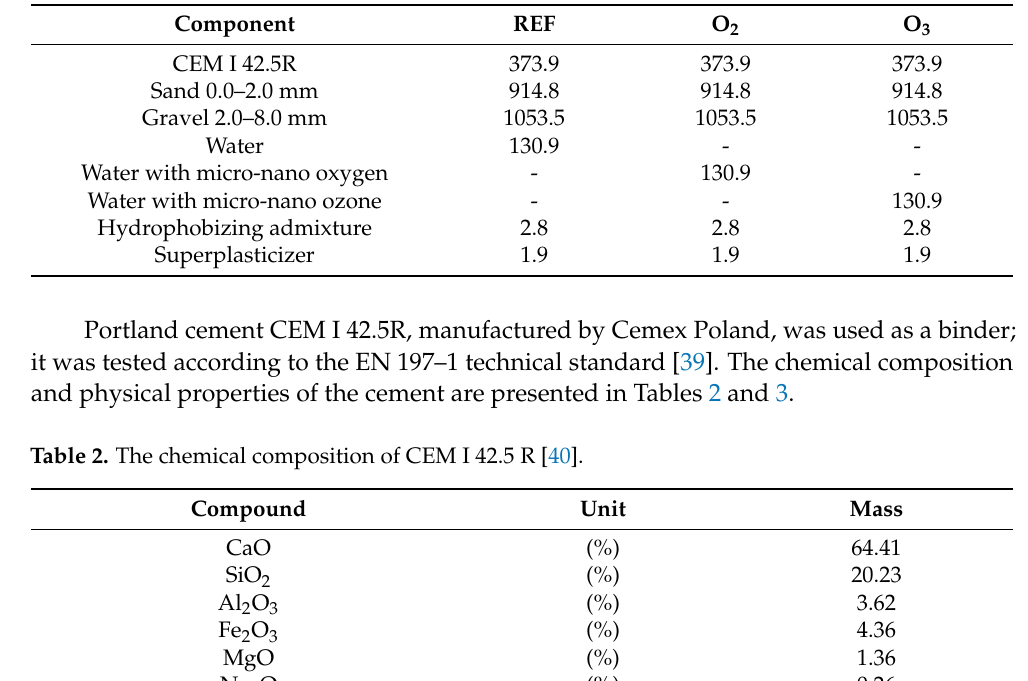
Figure 1. Concretes produced: (1) concrete with micro-nano oxygen bubbles; (2) concrete with micro-nano ozone bubbles; (3) references concrete. Table 1. Composition of concrete mixtures (kg/m 3 ; L/m 3 ).